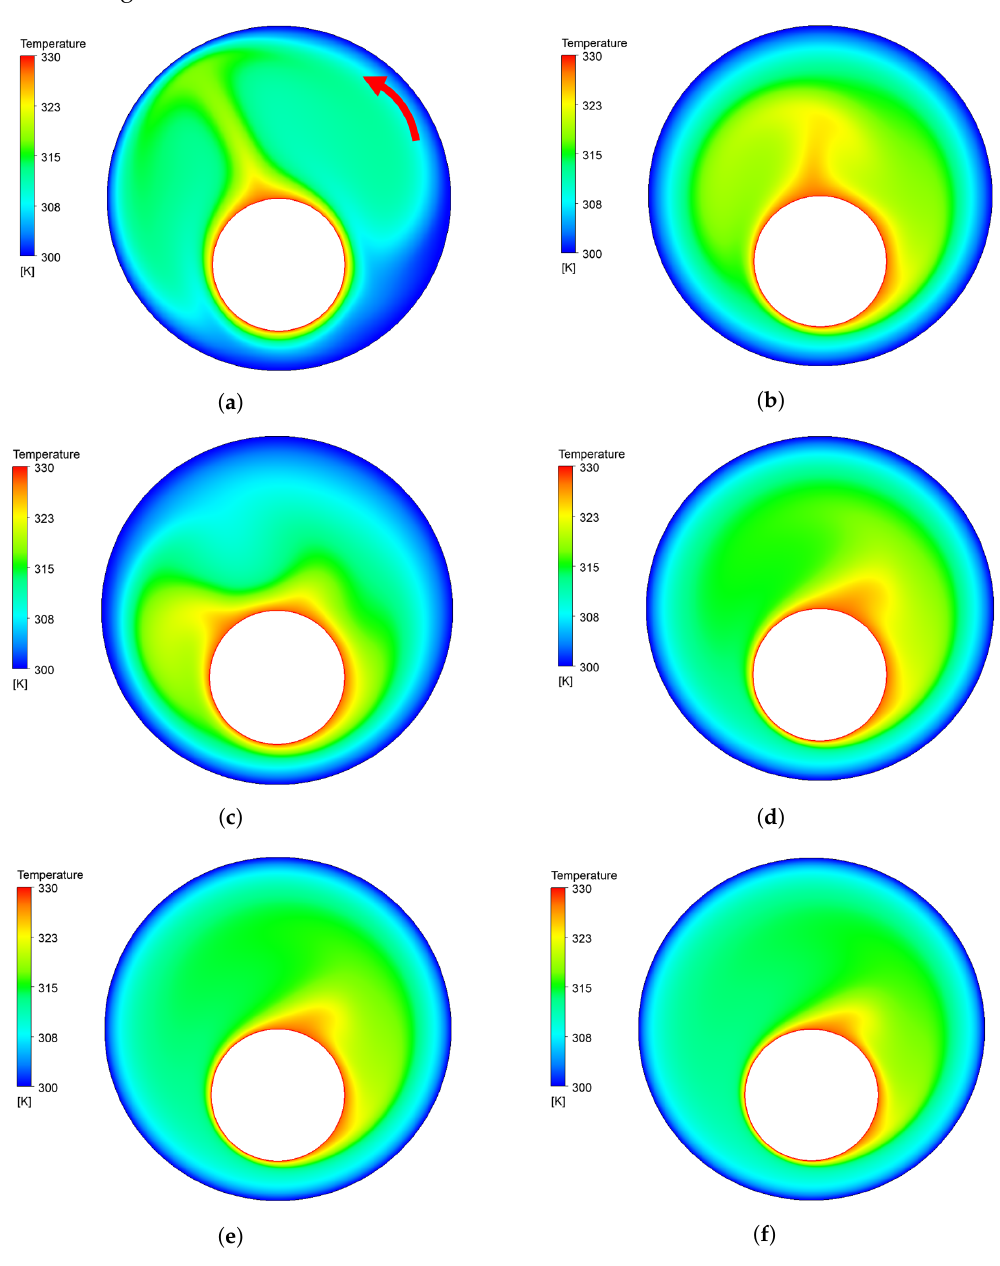
Figure 6. Numerical solutions for outer-counterclockwise cylinders: ( a ) 2 rad/s; ( b ) 5 rad/s; ( c ) 10 rad/s; ( d ) 15 rad/s; ( e ) 20 rad/s; and ( f ) 25